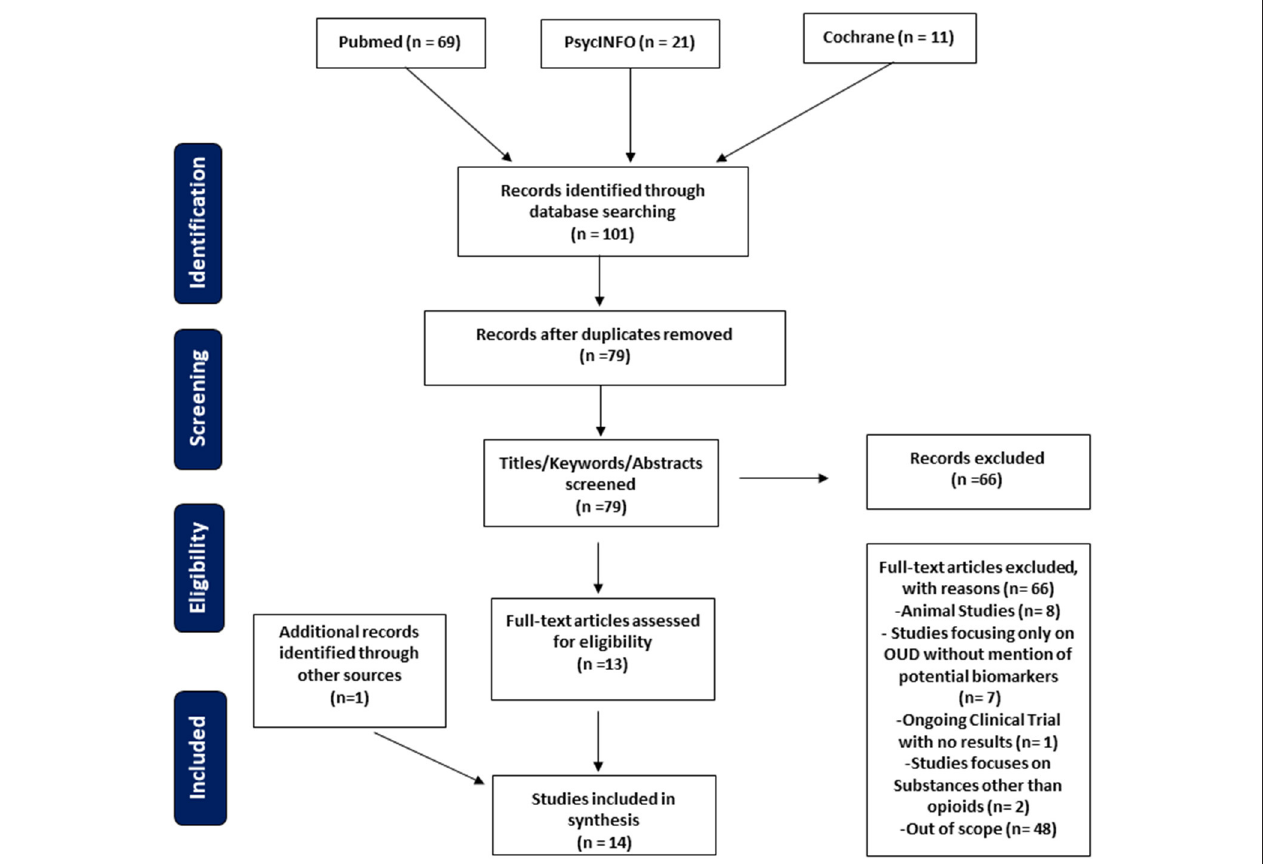
FIGURE 1 | PRISMA flow diagram of literature search and selection of